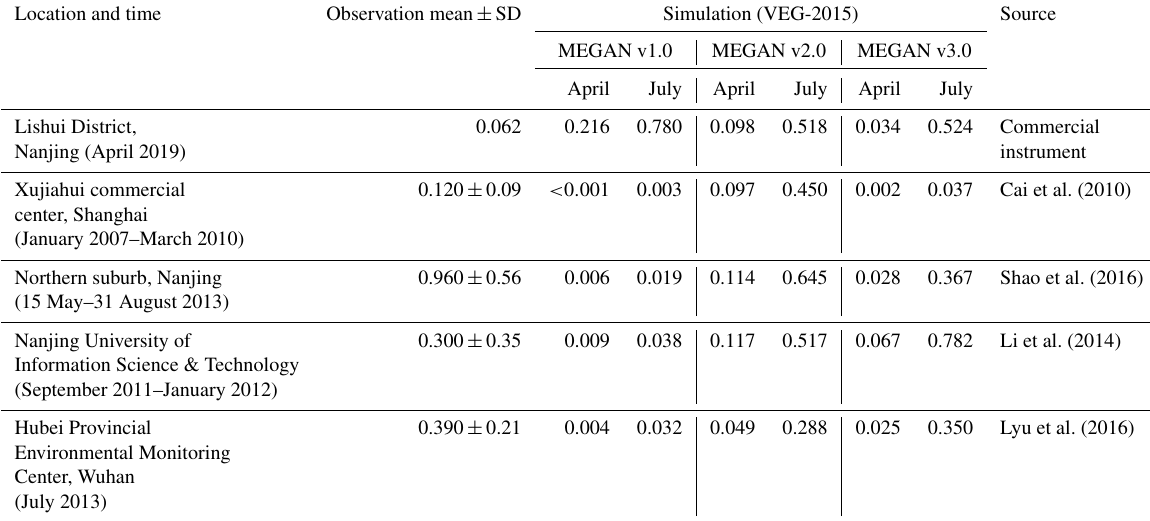
Table 4. Measured and simulated isoprene concentrations (ppbv) at sampling sites. Location and